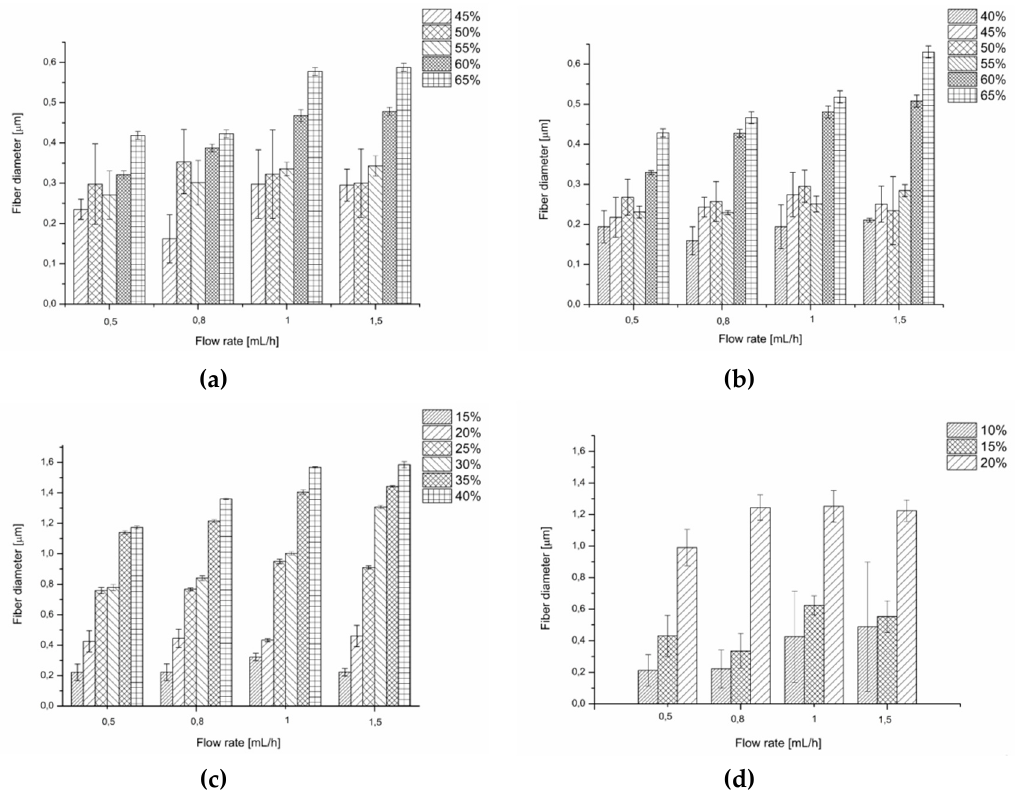
Figure 4. Comparison of the diameter and the uniformity of the diameter for fibres of ( a ) PiPrOx 21k in water, ( b ) PiPrOx 42k in water, ( c ) PiPrOx 21k in HFP, and ( d ) PiPrOx 42k in